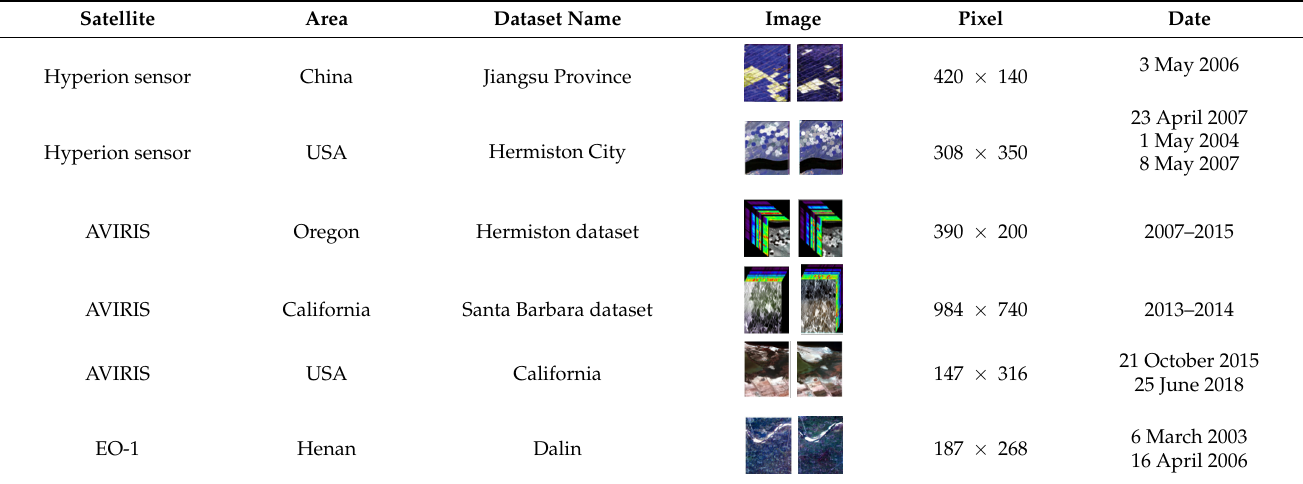
Table 6. Illustration of hyperspectral